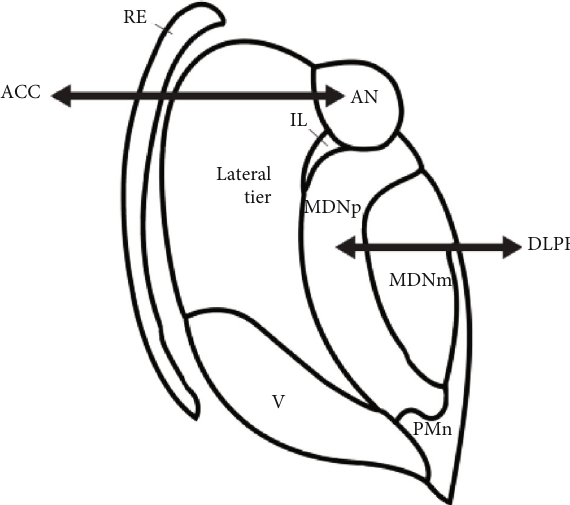
Figure 2: Postmortem Tissue Sample stained for visualization and delineation of thalamus subnuclei. Our delineation of the VPL follows that of the standardized nomenclature of Feremutsch and Simma in Dewulf [105]. We sampled from the portion of VPL in coronal sections through the caudal half of the centromedian nucleus (CM). At these levels, VPL is rather conspicuous due to its relatively larger and more coarsely staining neurons compared to surrounding nuclei. Moreover, these neurons, especially in the more lateral extent of the nucleus exhibit a prominent diagonal arrangement. The lateral boundary of the VPL is the external medullary lamina of the thalamus; its superior border, the dorsal posterior (DP) nucleus with more homogeneously arranged cells; it medial boundary is the anterior portion of the pulvinar with conspicuously smaller, paler, and more homogeneously arranged cells. Abbreviations: CM: centromedian nucleus; DP: dorsal posterior nucleus; eml: external medullary lamina; Li: nucleus limitans; MD: mediodorsal nucleus; Pu: